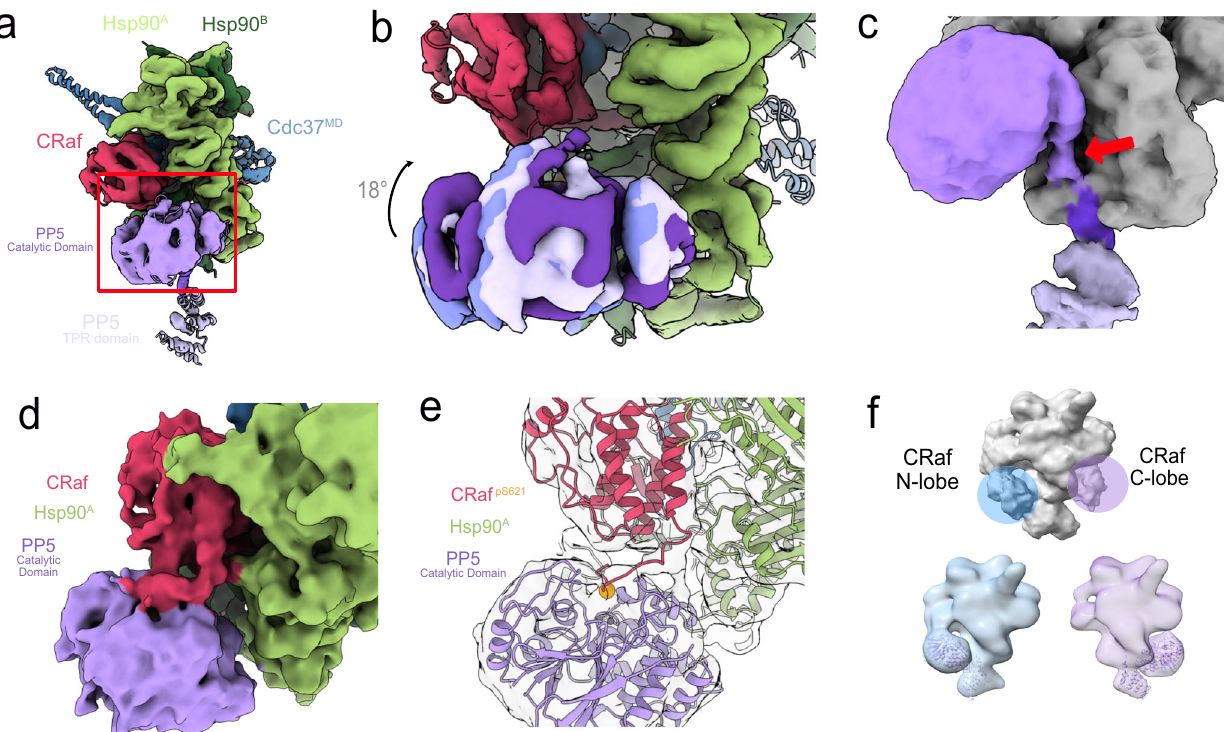
Fig. 4 | Heterogeneous PP5 catalytic domain is in position for CRaf pS621 dephosphorylation.a The PP5catalyticdomainsits byHsp90 MD allowing for CRaf kinase dephosphorylation. b Multiple PP5 conformations can be teased apart through focused classi fi cation. Anchored by its TPR domain, PP5 is fl exibly held in proximity to the CRaf pS621 . c In some classes, the PP5 linker can be seen leaving the Hsp90 CTD groove and leading up to the PP5 active site. d A frame from a 3D variability analysis movie (Supplementary Movie 3) shows density spanning between the C-terminus of CRaf and the PP5 active site. e Focused classi fi cation of the interface between the CRaf C-lobe and the catalytic domain yields a